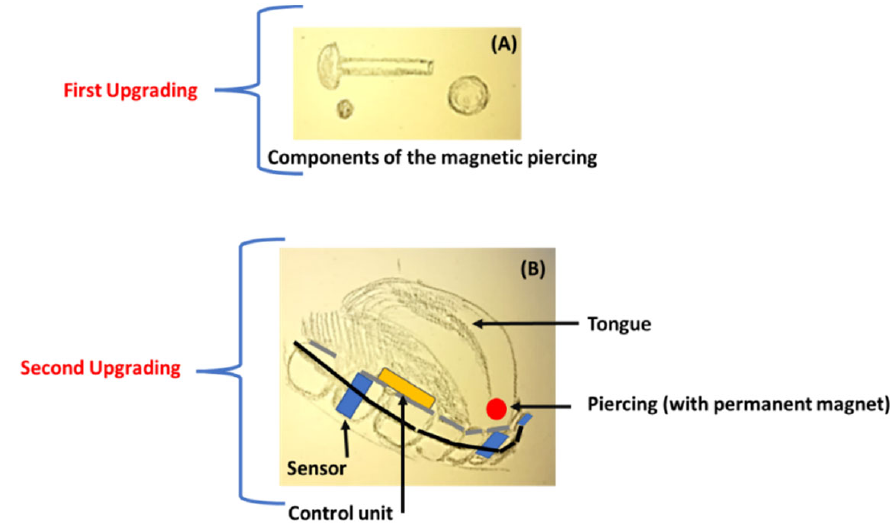
Figure 3. Sketch (realized by D.G.) of the upgrade to the TDS: ( A ) the introduction of the magnetic piercing; ( B ) the introduction of the oral control unit.